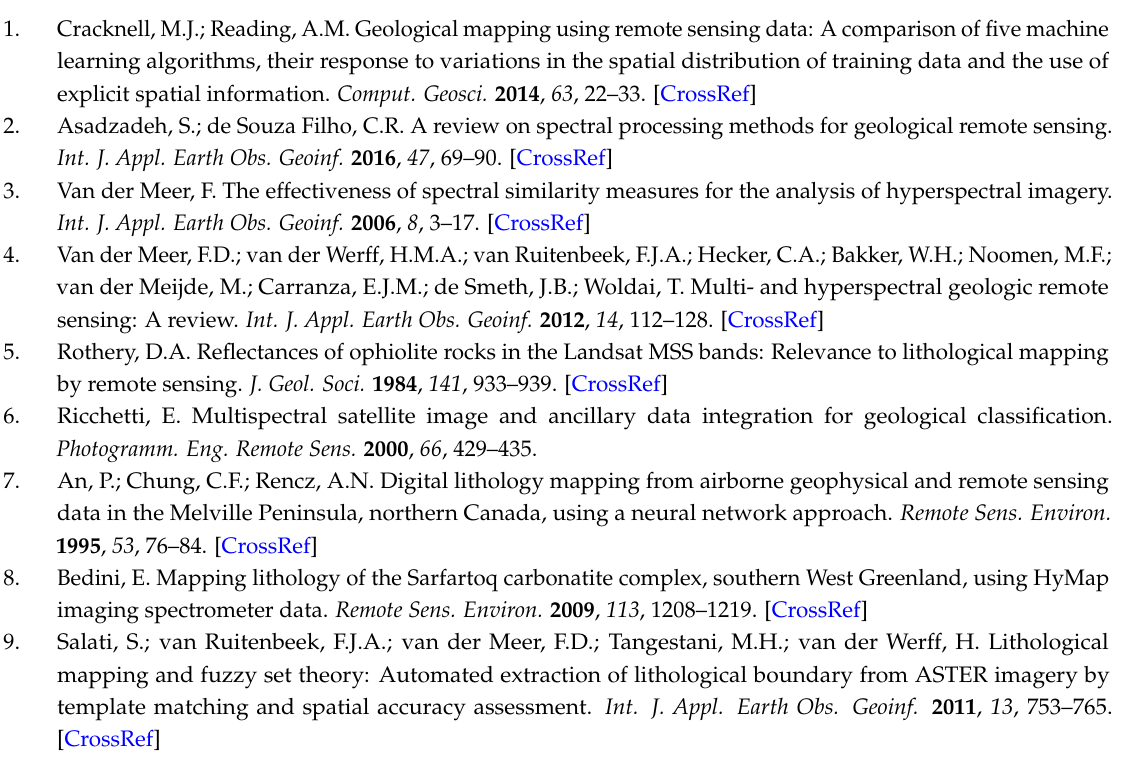
Table S1: Confusion matrix for the OBIA classification of the Li dataset, Table S2: Confusion matrix for the OBIA classification of the ATM 9 dataset, Table S3: Confusion matrix for the OBIA classification of the ATM PC dataset, Table S4: Confusion matrix for the OBIA classification of the ATM MNF dataset, Table S5: Confusion matrix for the OBIA classification of the ATM-Li dataset, Table S6: Confusion matrix for the OBIA classification of the ATM-Li MNF